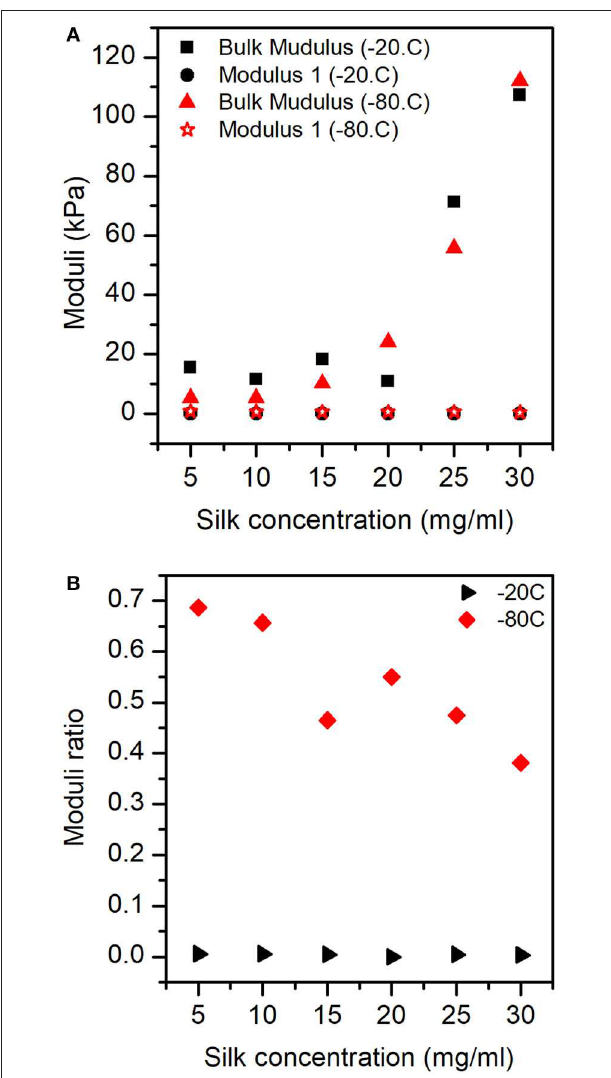
FIGURE 8 | Moduli responses for the sponges in different concentrations of silk and process temperature: (A) Bulk modulus and Modulus 1. (B) Ratio between Modulus 1 and Bulk modulus.